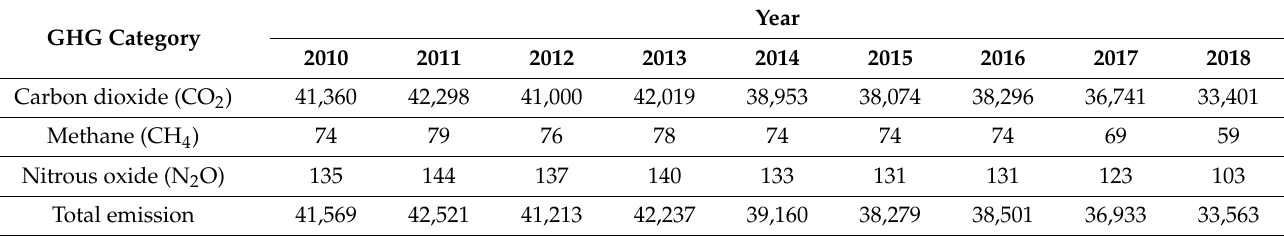
Table 3. Taiwan’s GHG emissions from the manufacturing and construction industries in terms of categories of GHG since 2010 1 .